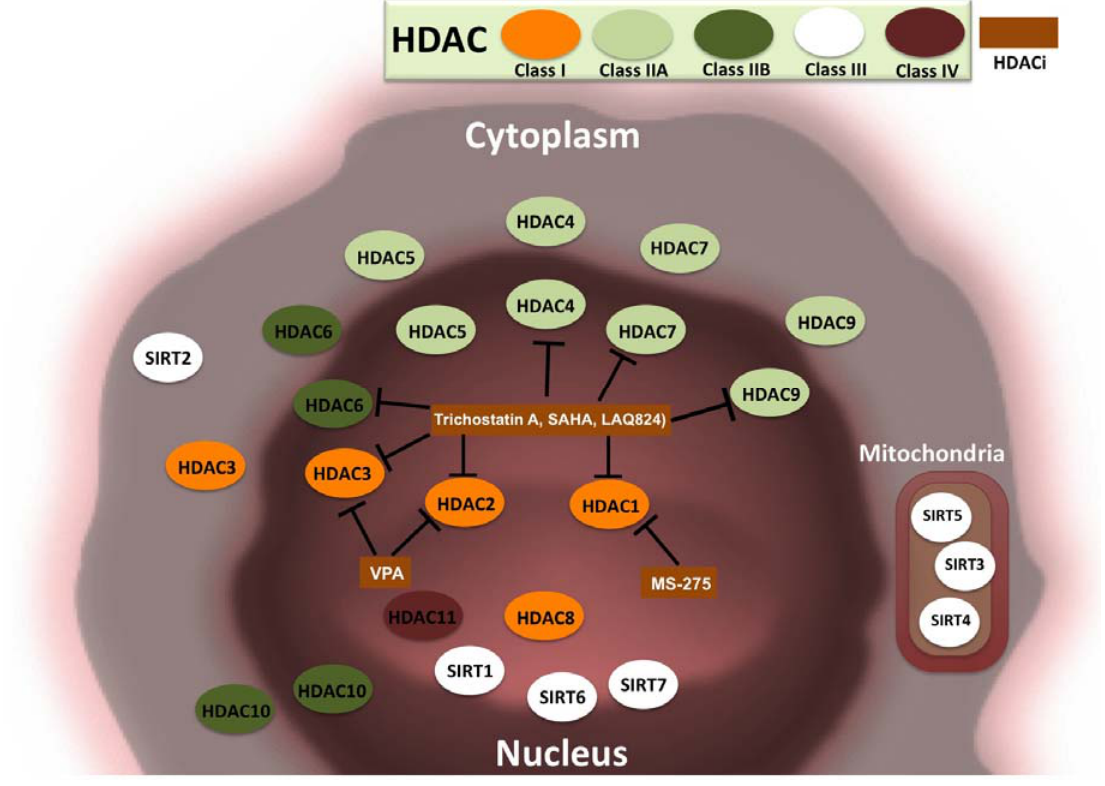
Figure 3. HDAC classes, their cellular localization, and inhibitory activities of certain HDAC inhibitors. A total of 18 HDACs belonging to four major classes of HDACs and their localization in cells are illustrated. HDACs that can localize to the cytoplasm and nucleus are indicated in both locations. Some notable HDAC inhibitors (HDACi) like trichostatin A, SAHA, NVP- LAQ824, valproic acid (VPA), MS-275 and their target HDACs on which they exhibit potent activity are also